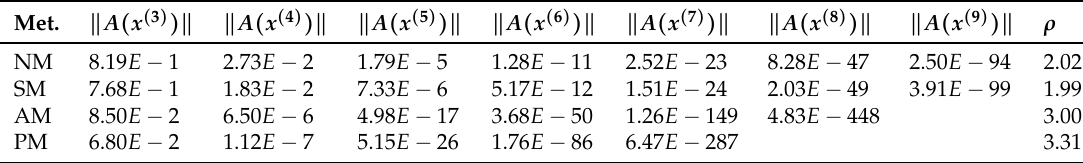
Table 1. Comparison evidences for Example